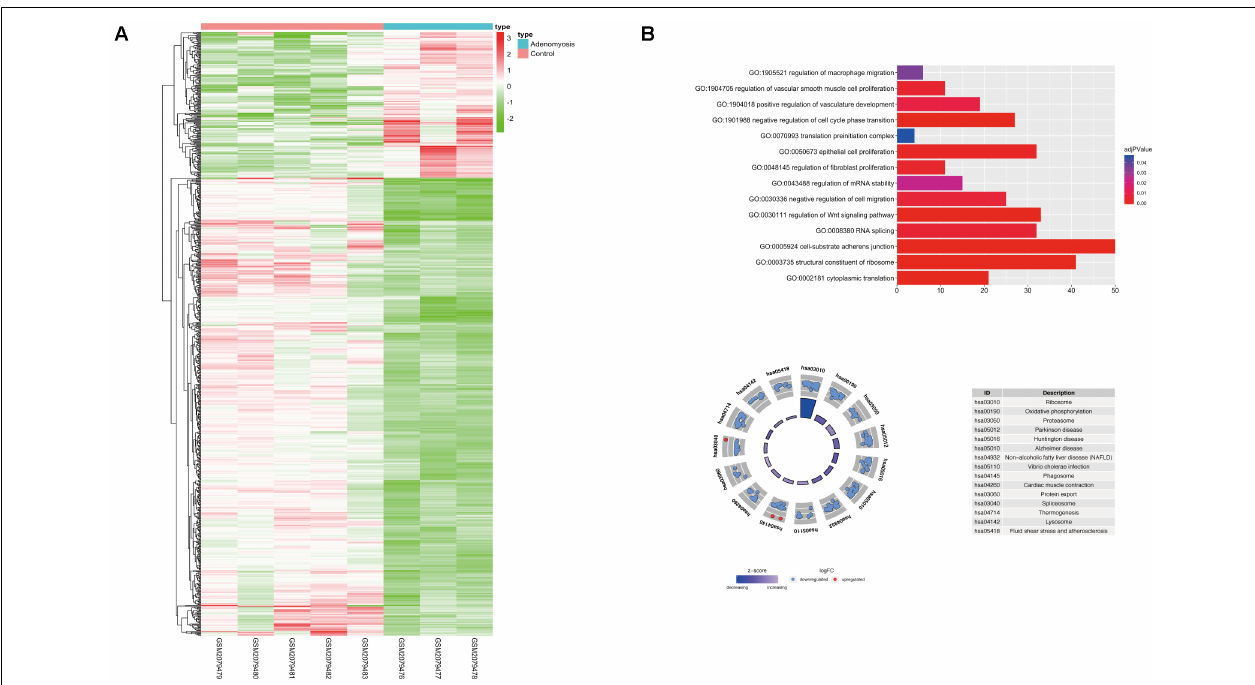
FIGURE 2 | The expression, functional enrichment of DEGs in the eutopic endometrium of women with and without adenomyosis. (A) The differentially expressed transcripts in the eutopic endometrium of adenomyosis patients versus controls (3 adenomyosis patients and 5 controls). (B) Functional annotation of the DEGs of eutopic endometrium using GO terms of biological processes (upper) and KEGG pathway